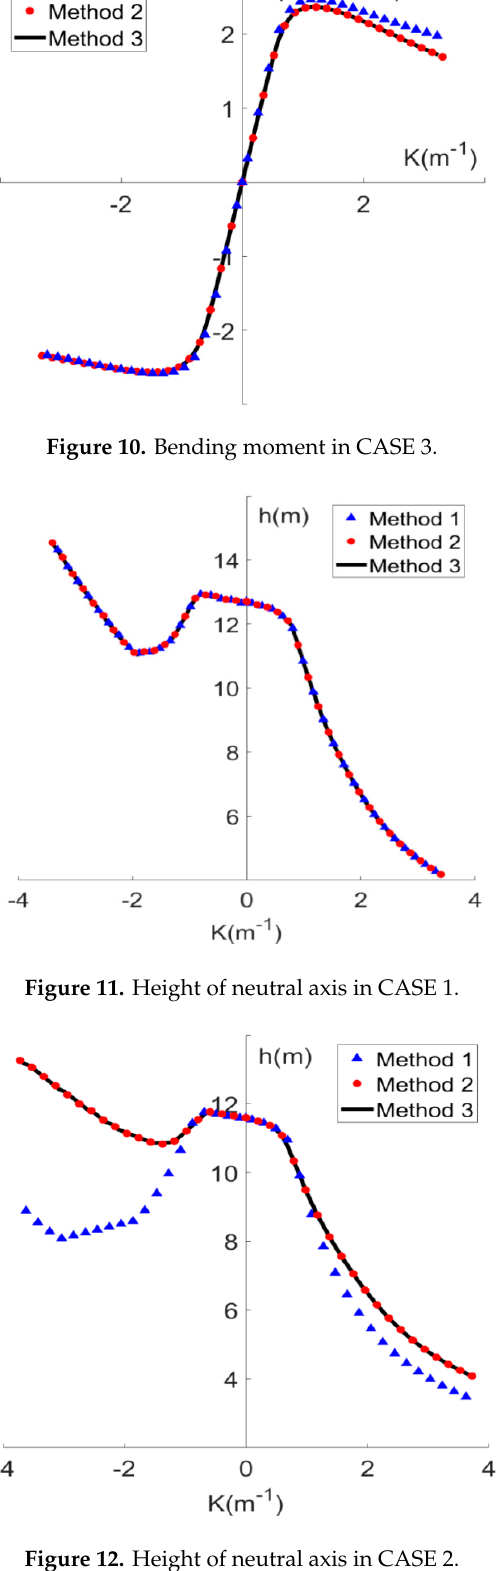
Figure 12. Height of neutral axis in CASE 2.